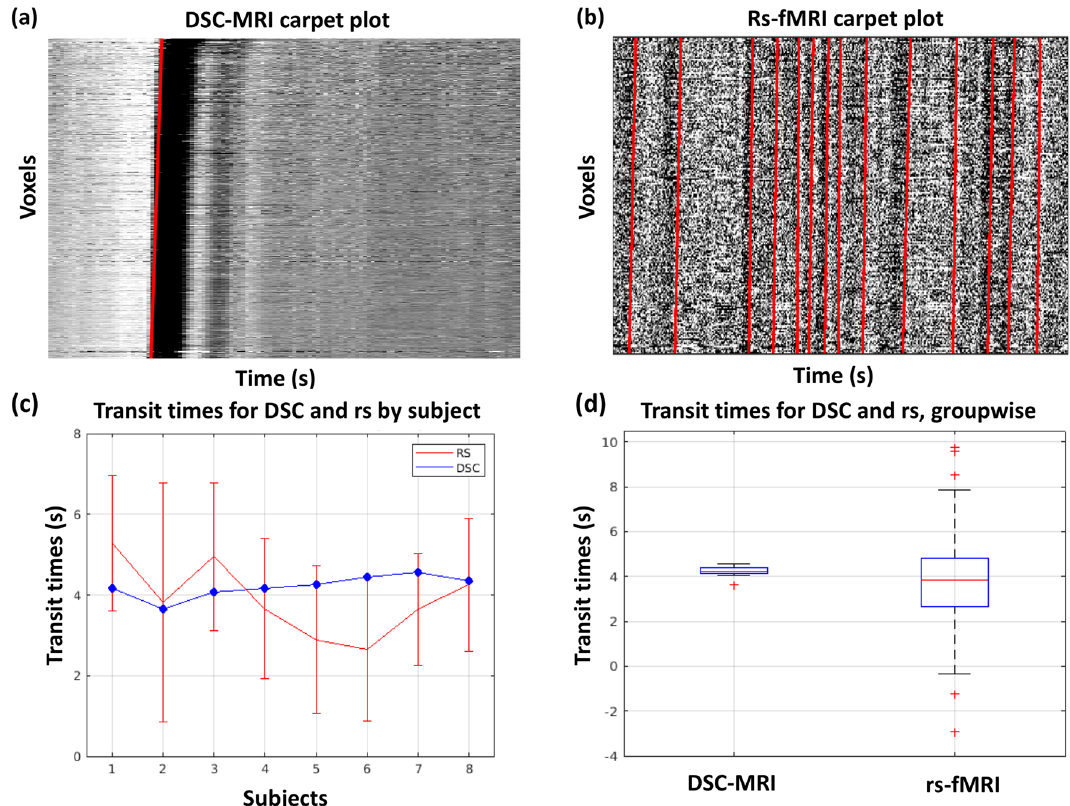
Figure 3. Comparison of edges and transit times computed for DSC and rs-fMRI carpet plots. Carpet plots are displayed for DSC-MRI ( a ) and rs-fMRI ( b ) of the same subject, with identified slopes marked in red lines. Transit times derived from each identified slope for DSC and rs-fMRI carpet plots for all individual subjects are shown in ( c ) . The corresponding box plot of the groupwise comparison of DSC and rs-fMRI transit times is shown in ( d ) . The 95% confidence interval for the difference between the groupwise medians of DSC-MRI and rs-MRI transit times is [− 0.49, 1.23